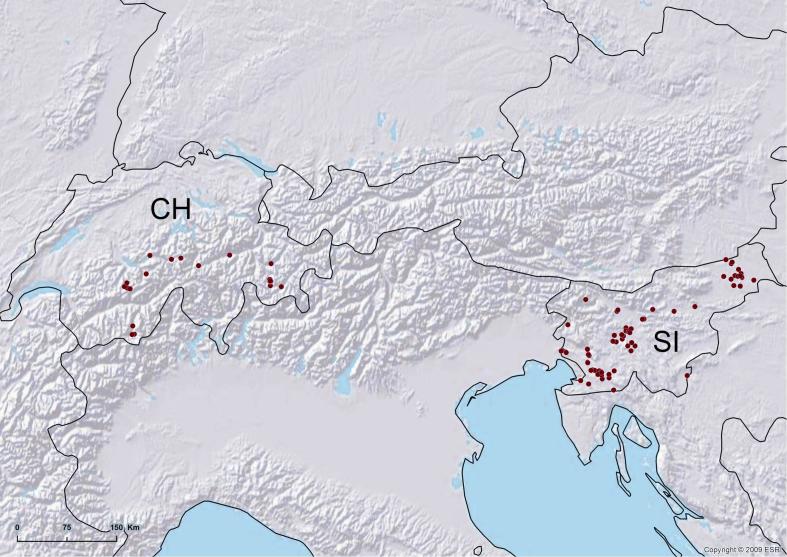
A map of central Europe with sampling localities indicated. Legend: SI = Slovenia; CH = Switzerland